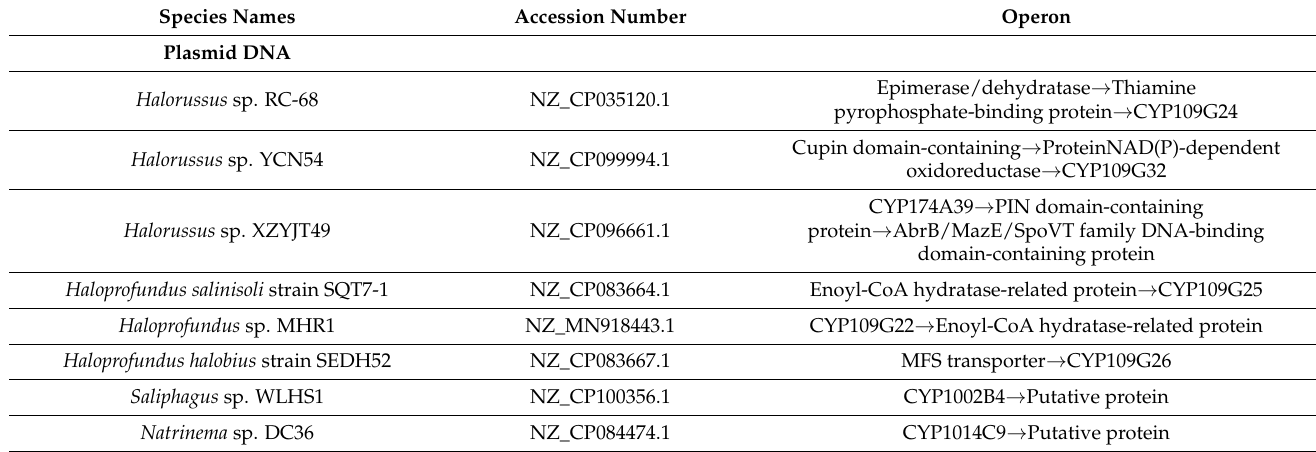
Table 2. P450 operon analysis in 40 archaeal species. Arrows indicate gene